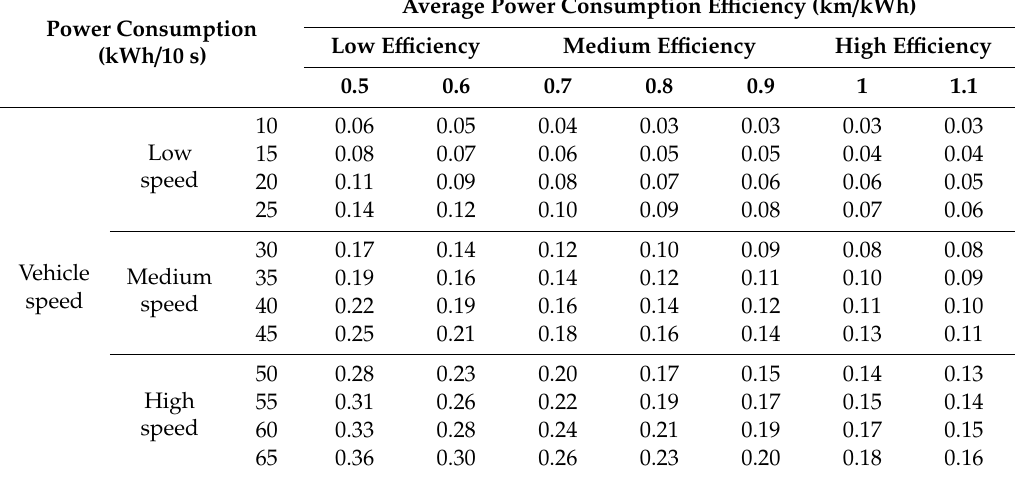
Table 2. Power consumption